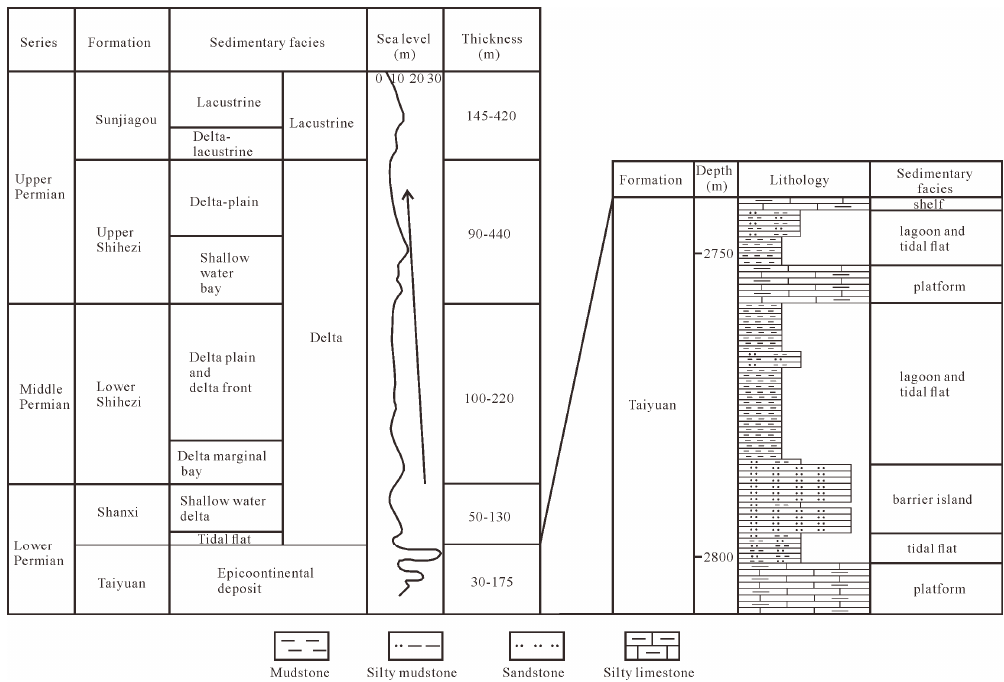
Figure 2. Map showing the stratigraphic column of Permian successions in the SNCB (modified from [38]) and more details of Taiyuan Formation (well wc1), including burial depth, lithology, sedimentary facies.